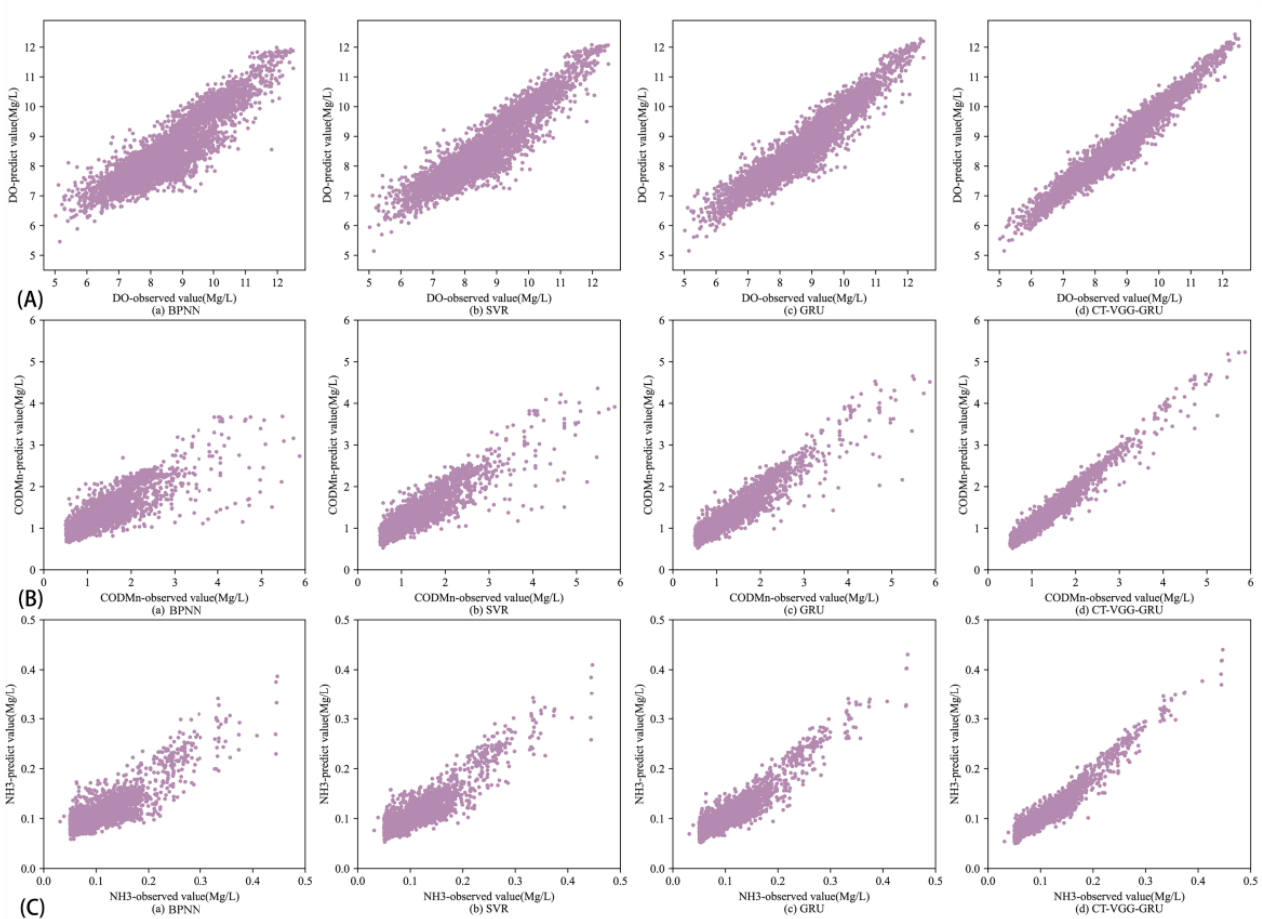
Figure 9. Scatter plots of comparison models: ( A ) DO, ( B ) COD Mn , ( C ) NH 3 -N.